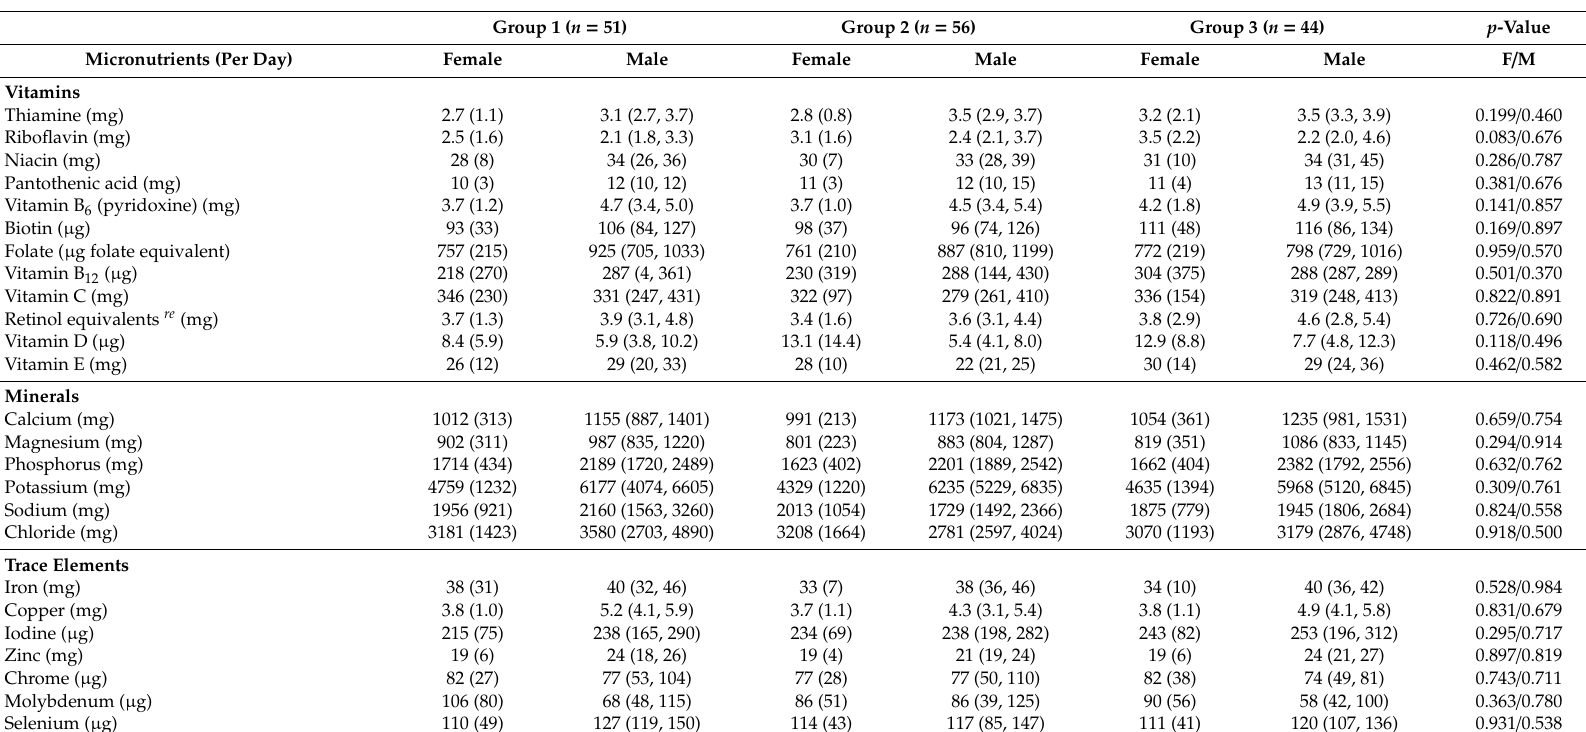
Table 3. Intake of selected vitamins, minerals, and trace elements by gender and to the time in WFPB lifestyle program: short (0.5– < 2 years), medium (2– < 5 years), and long-term (5–10 years) (groups (1, 2 and 3)).